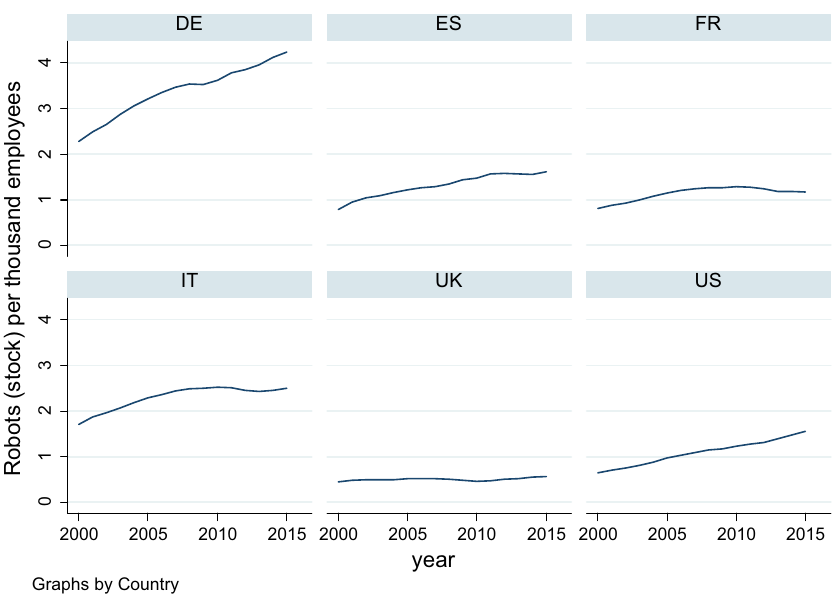
Fig. 3 Penetration of industrial robots (selected countries). Source : WRIB and EU KLEMS